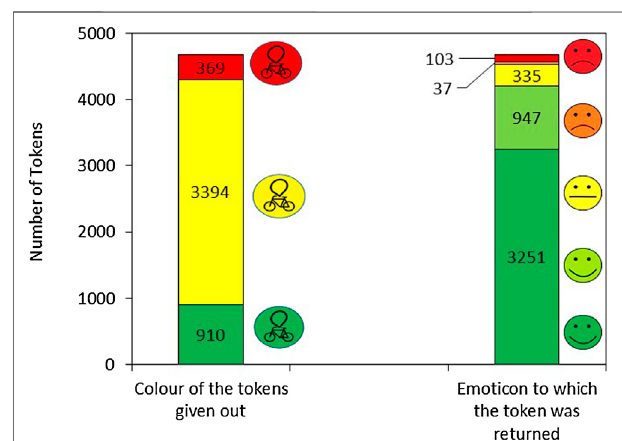
FIGURE 6 | A total of 4,673 participants ’ opinions were recorded. The color of the segments in the fi rst bar corresponds to the color of the token issued to a participant, red, yellow or green. The color of the segments in the second bar indicates where the participant left their token, according to how they felt about a hydrogen powered future, ranging from dark green indicating very positive to red indicating very